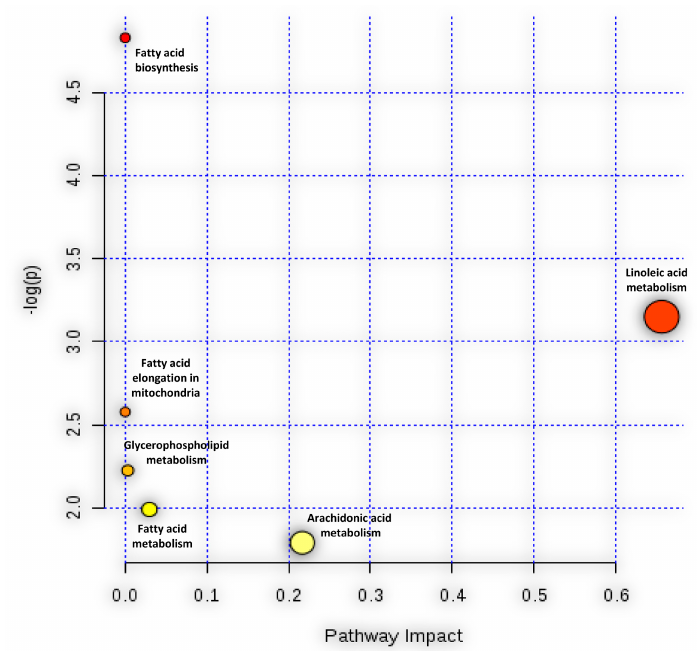
Figure 4. Pathway analysis associate with HCoV-229E infection was carried out by MetaboAnalyst. The Y -axis, “log(p)”, represented the transformation of the original p -value calculated from the enrichment analysis. The X -axis, “Pathway Impact”, represented the value calculated from the pathway topology analysis.